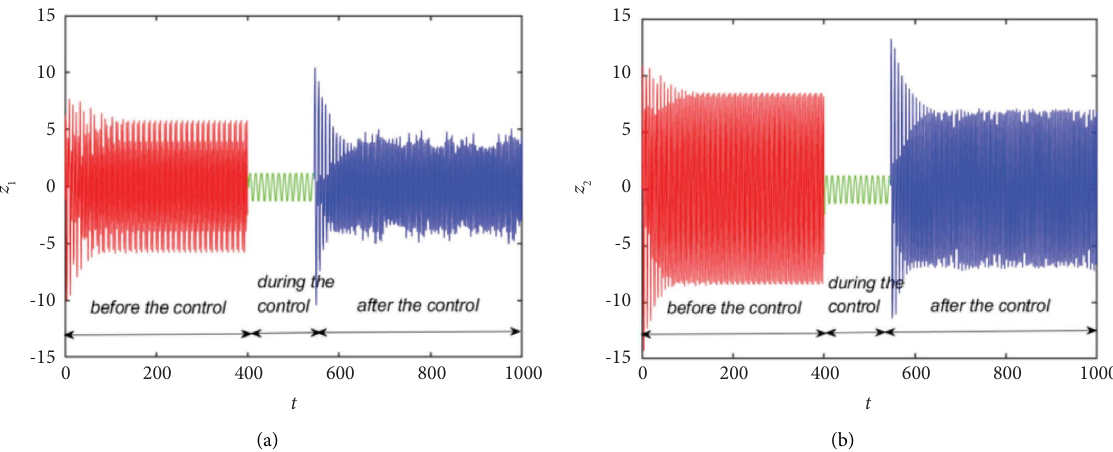
Figure 14: Te time history of the system responses under the OLPNCL control. (a) Te mechanical equipment vibration response. (b) Te NES vibration